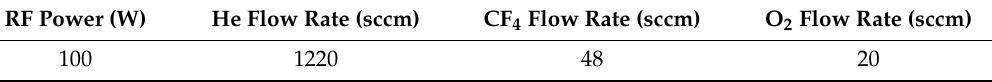
Figure 2. Experimental setup of APPP. Table 1. Processing parameters of APPP.